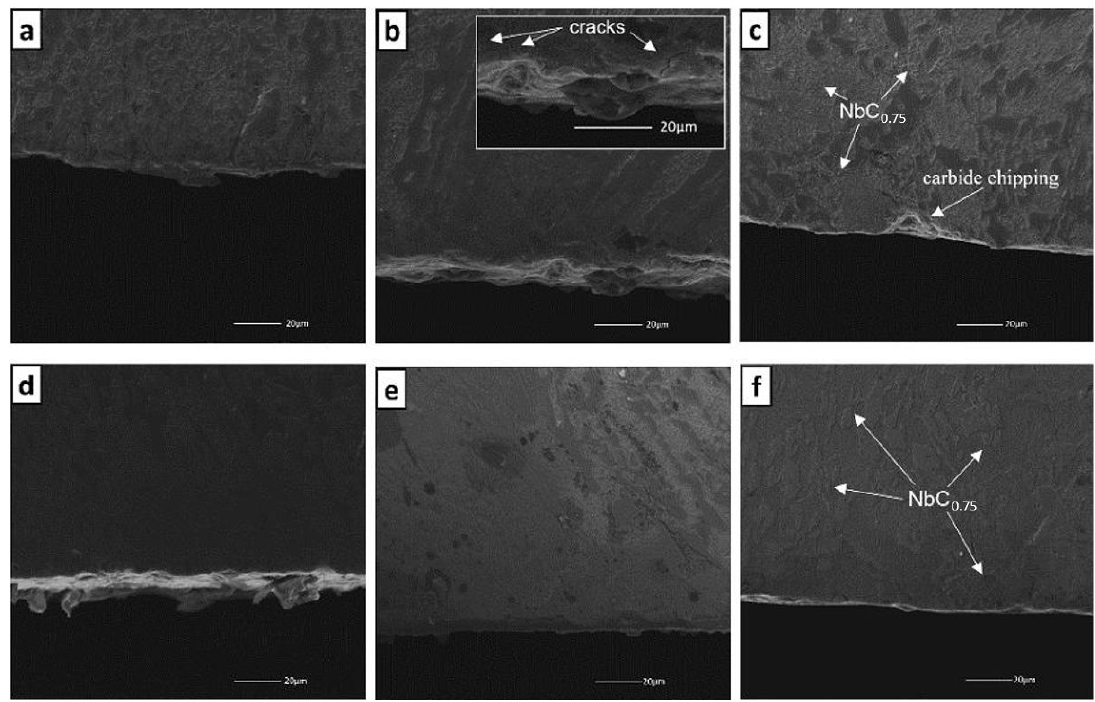
Figure 15. Cross-sectional scanning electron microscopy at 130N (upper line) and 45N (lower line): (a, d) HCCI0%Nb; (b, e) HCCI0.5%Nb; (c, f) HCCI1%Nb.